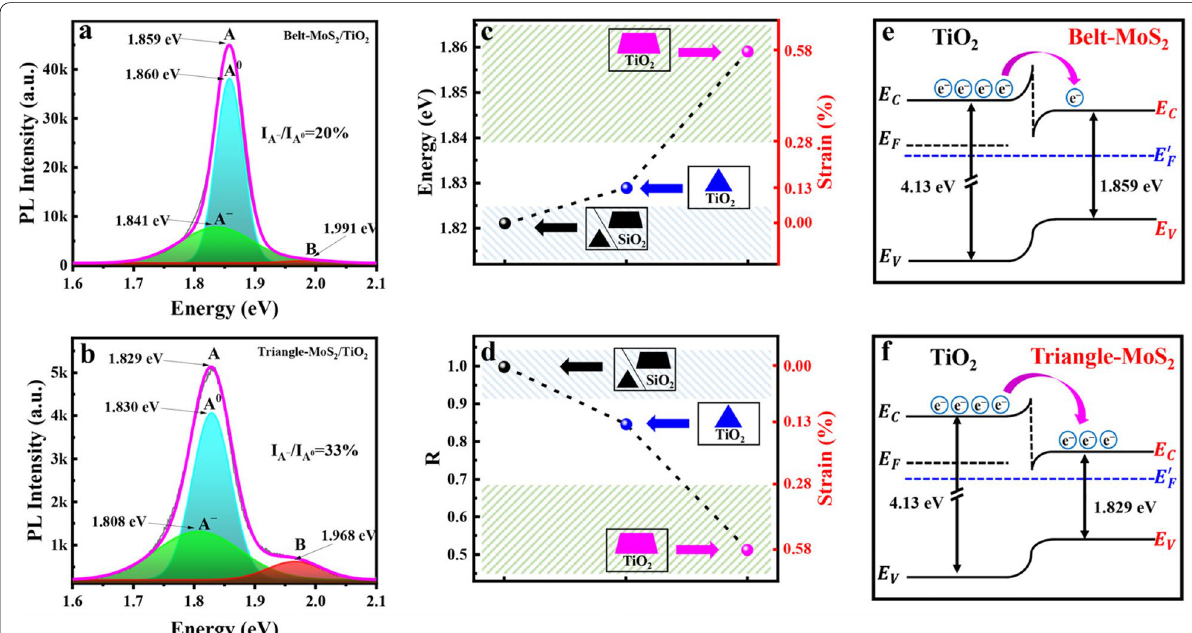
Fig. 5 a , b PL spectra of the belt-like and triangular ML MoS 2 patterns on TiO 2 (001) surface were fitted by Gaussian function. The relationship of the energy position ( c ) and the intensity ratio of A − and A 0 ( d ) of the as-grown and the after-transfer samples with the strain. e , f The structural schematic model of the energy band realignment in the interface between the belt-like MoS 2 /TiO 2 and the triangular MoS 2 /TiO 2 ,